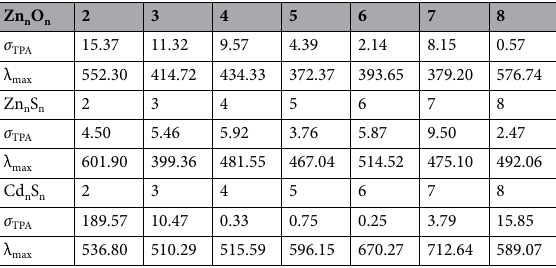
Table 4. The TPA cross section σ TPA (GM) and their corresponding maximum absorption wavelength λ max (nm) of Zn n O n , Zn n S n , and Cd n S n , n =